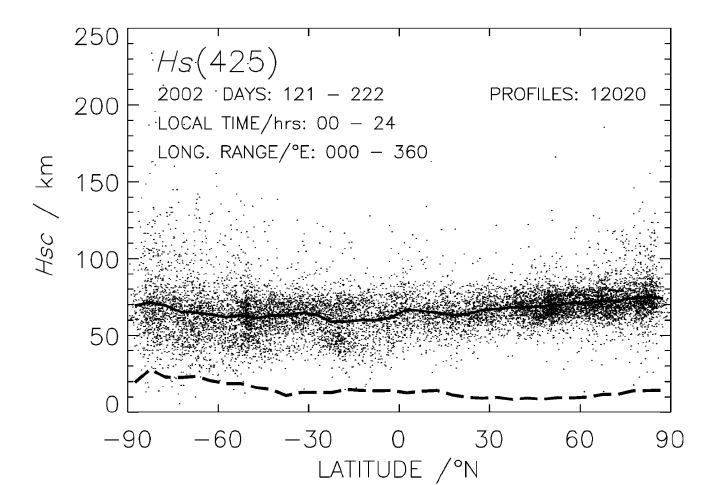
Fig. 7.11. Latitudinal distribution of the topside scale height taken at 425 km height at all longitude sectors over 24 h. The dashed curve represents the standard